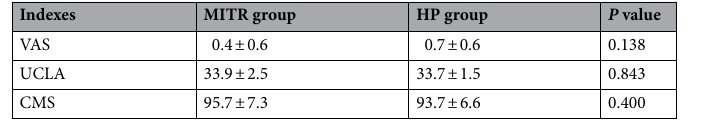
Table 2. Comparison of different scores in both groups (mean ± SD). VAS visual analog scale, UCLA University of California at Los Angeles Shoulder score, CMS Constant–Murley Score, MITR minimally invasive coracoclavicular fixation with a single TightRope, HP hook